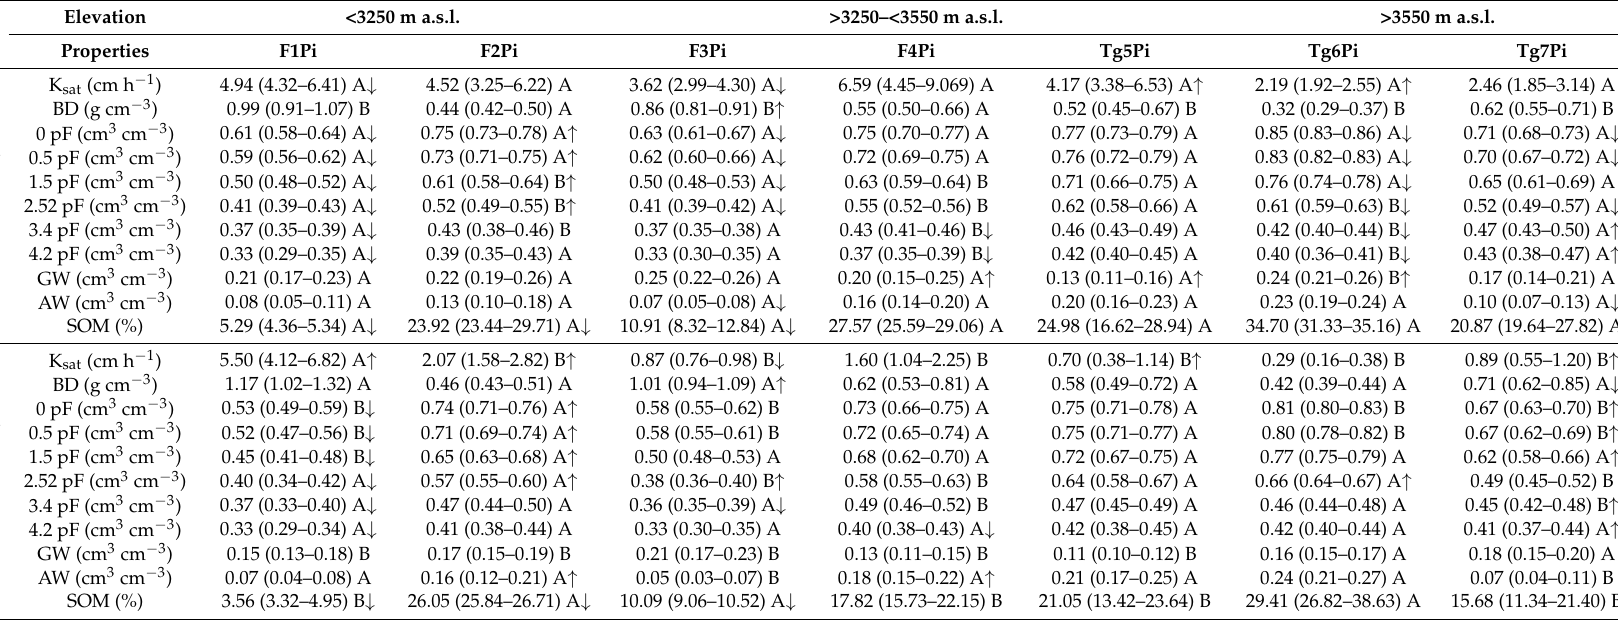
Table A2. Median and the 25th and 75th percentile of the hydro-physical properties and SOM content of the soil in the high montane forest and p á ramo converted to pine plantation (F = high montane forest; Tg = p á